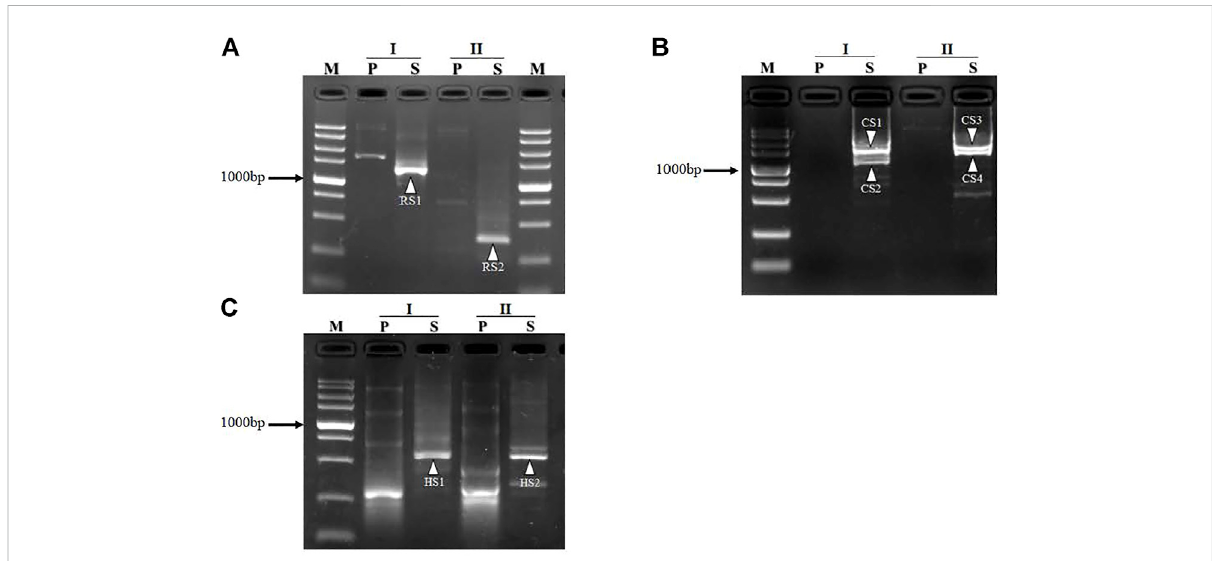
FIGURE 1 Mining unknown regions fl anking gadR (A) and gadC (B) in Lactobacillus brevis CD0817 and hyg (C) in rice. I and II denote the two sets of FPR- PCRs in each round of walking. The bands RS1-RS2, CS1-CS4, and HS1-HS2, indicated by white arrowheads, are the secondary PCR products for gadR , gadC , and hyg , respectively. Lane P, primary PCR; lane S, secondary PCR; lane M, TaKaRa DL5000 DNA marker (from top to bottom 5000, 3000, 2000, 1,500, 1,000, 750, 500, 250, and 100